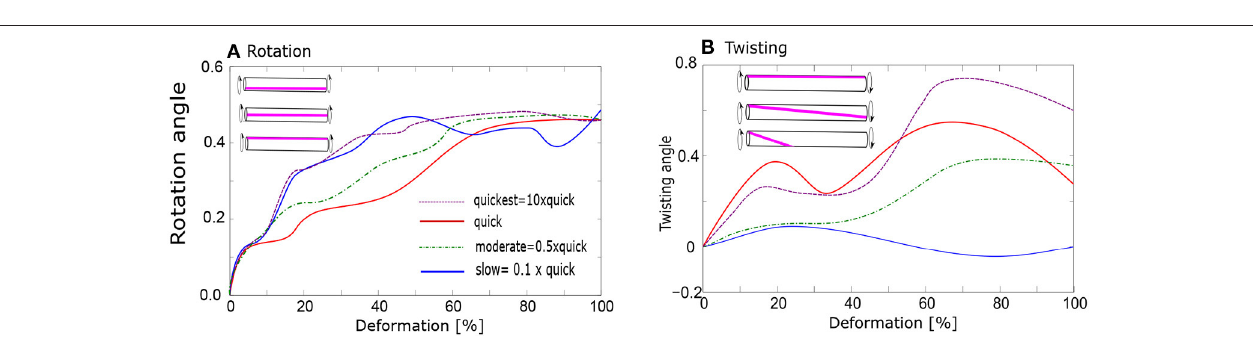
FIGURE 9 | Evolution of bundle geometry during deformation; (A) Rotation of bundles: average rotation angle of bundles (in radians) from the beginning of the deformation; (B) Twisting of bundles: average twisting angle of bundles (in radians). Various stretching rates: 10 × quick, quick, moderate, and